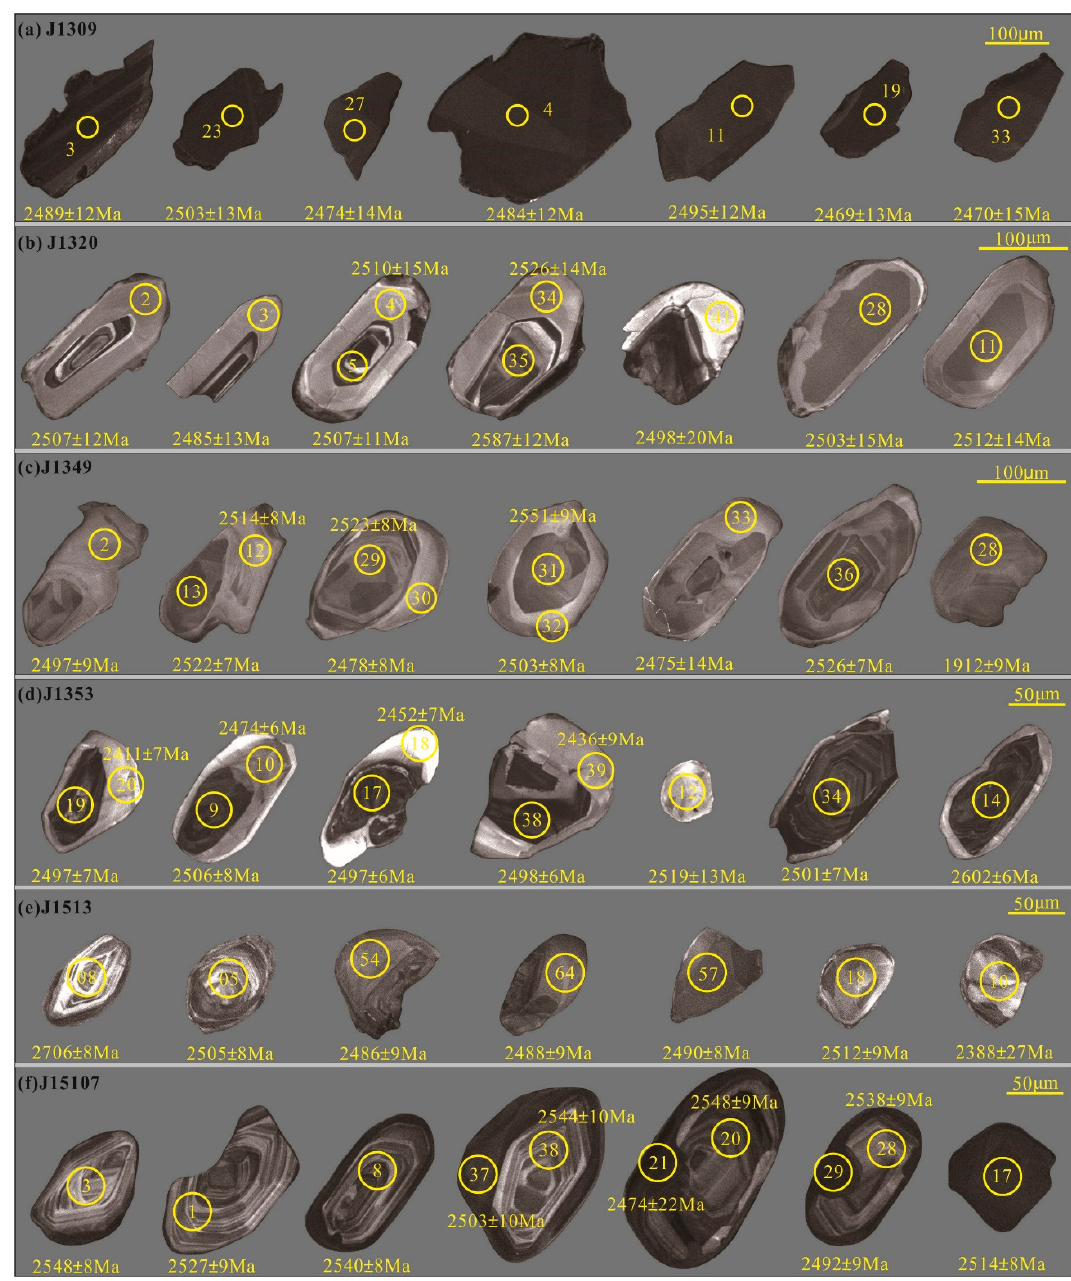
Figure 5. CL images of representative zircon grains showing analyzed locations, internal struc- tures and apparent 207 Pb/ 206 Pb ages. The solid circles in CL images show positions of LA-ICP-MS analytical sites, with their identification numbers as in Table S1, Th/U ratios and ages in Ma, respectively. ( a ) J1309 syenogranite; ( b – d ) J1320, J1349, J1353 orthogneisses; ( e , f ) J1513, J15107 felsic paragneisses.